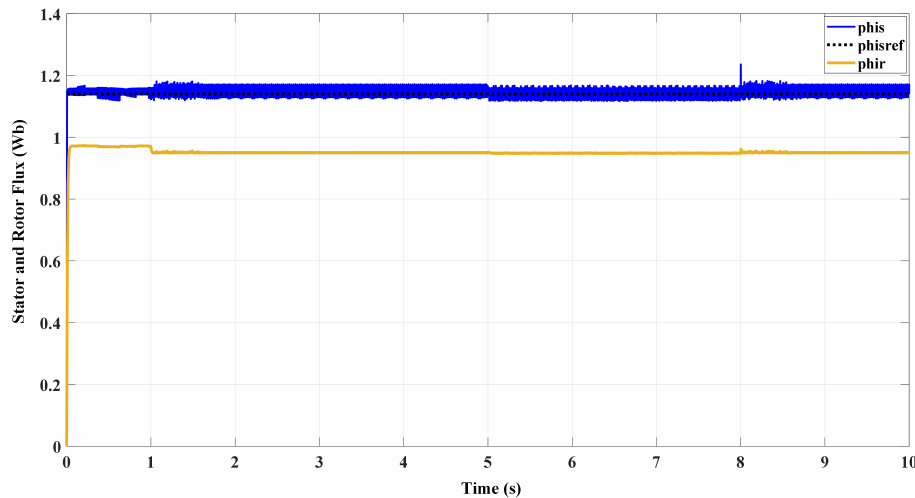
Figure 9. Responses of the stator and rotor fluxes in the proposed strategy.